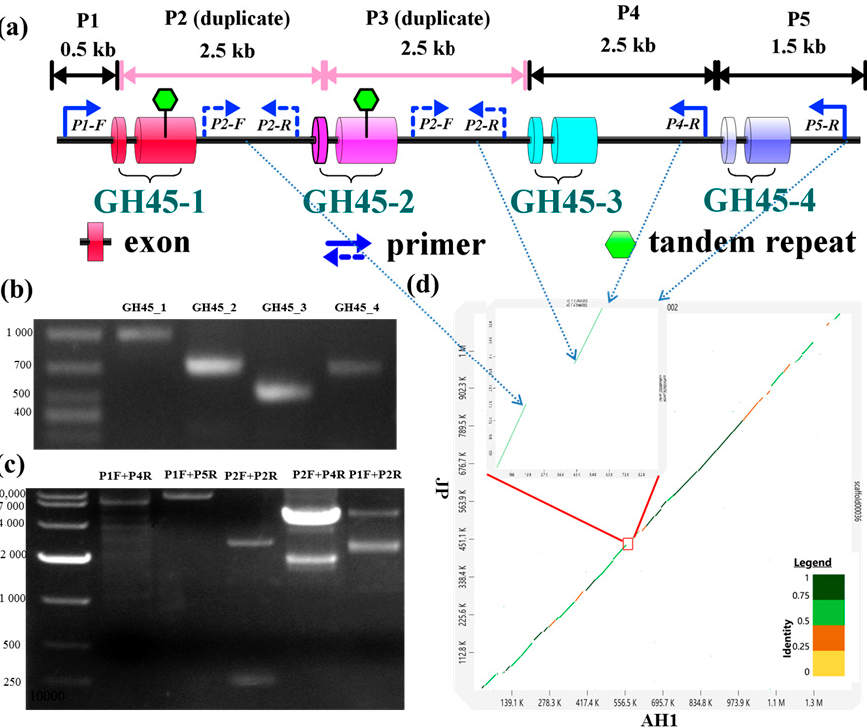
Figure 1. Identification of multi-copy Glycoside hydrolase 45 (GH45) genes. ( a ). Visualization of genome locations of GH45 genes, ( b ). PCR amplification of 4 GH45 genes using AMA3 cDNA, ( c ). PCR amplification of intergenic regions among GH45 genes and ( d ). Genome comparison of GH45 genes found in AH1 against JP; the missing copies GH45_2 and GH45_4 are highlighted in the red rectangle.